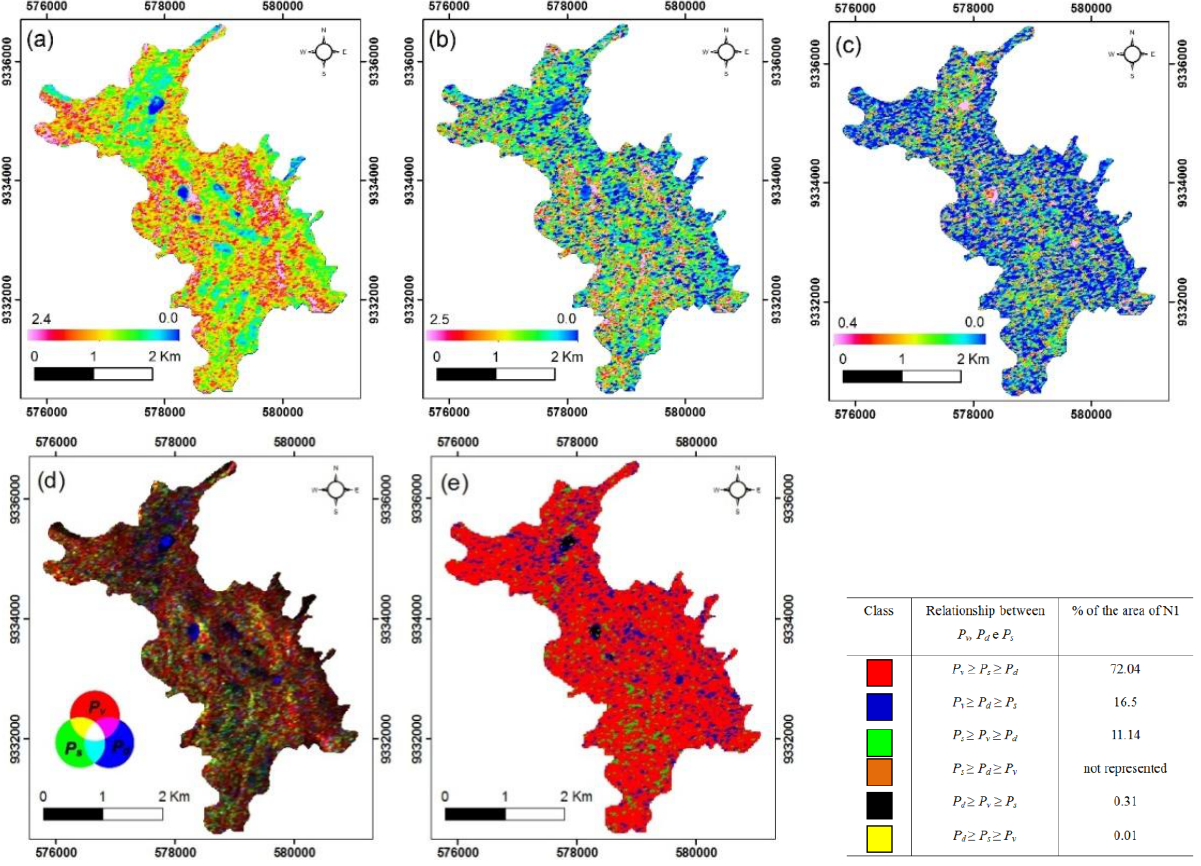
Figure 9. Intensities corresponding to the Freeman-Durden decomposition derived from the RADARSAT-2 image: ( a ) volumetric scattering P ; ( b ) surface scattering P v ( c ) double-bounce scattering P ; ( d ) the mechanisms are combined through a color d composite image (R— P , G— P , B— P ); ( e ) Classes labeled according to the relationship v s d between the types of scattering mechanism derived from the Freeman-Durden decomposition